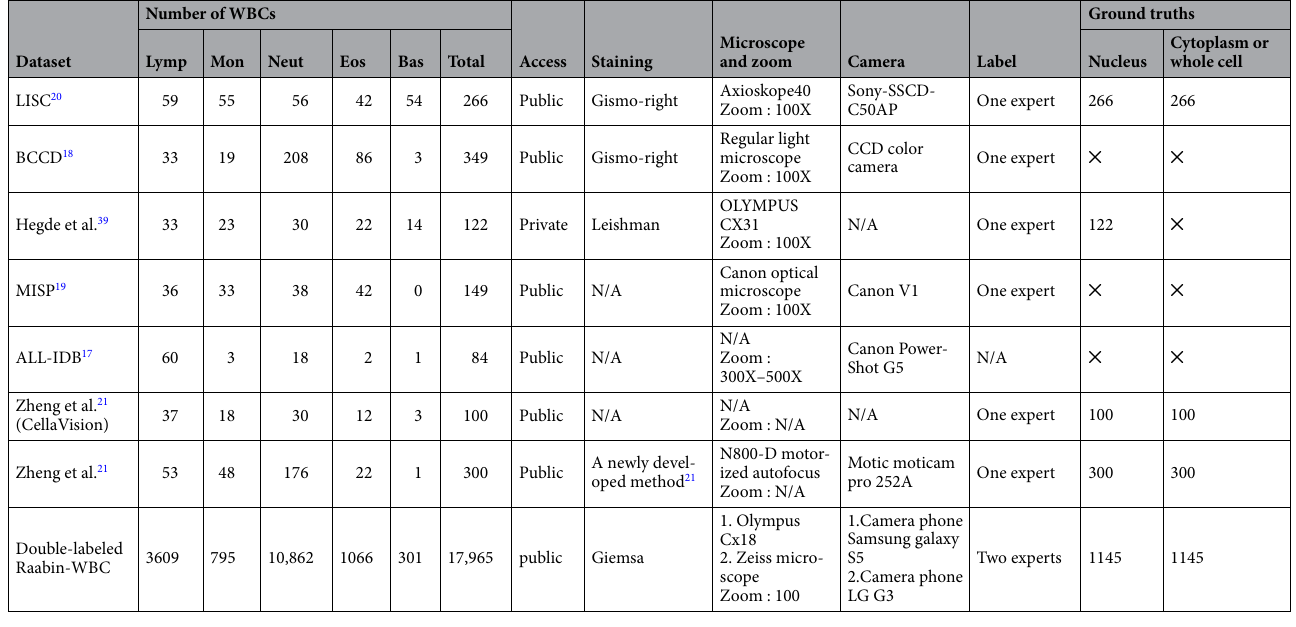
Table 6. Comparing some datasets with double-labeled Raabin-WBC. Double-labeled Raabin-WBC does not contain the repeated samples as well as includes only five general cells (lymphocyte, monocyte, neutrophil, eosinophil, and basophil).